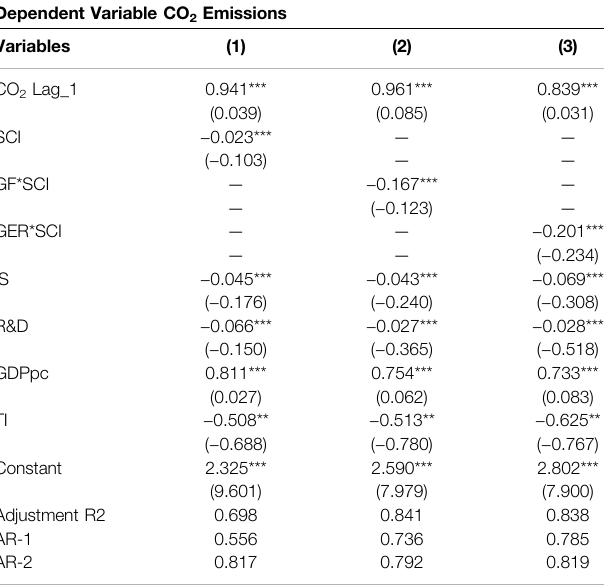
TABLE 4 | Results of the impact of supply chain performance on CO 2